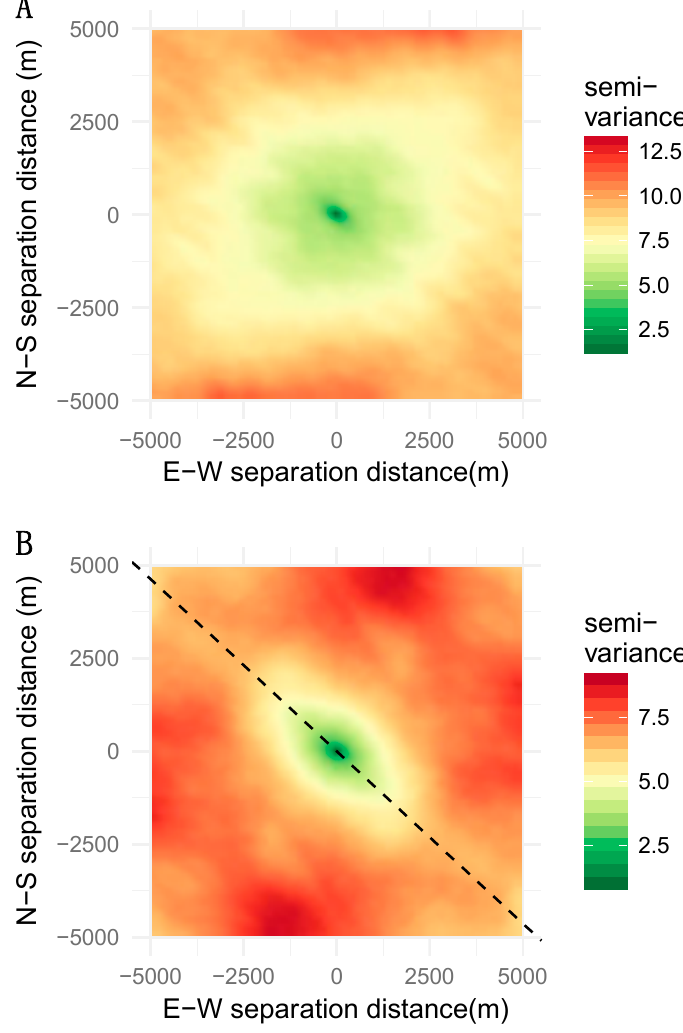
Figure 5. Variogram maps for the first two axes of the PCA of landscape metrics describing the urban structure of the city of Niamey: ( A ) variogram map for axis 1 revealing an isotropic variation; ( B ) variogram map for axis 2 showing the presence of anisotropy in the direction of 135°.